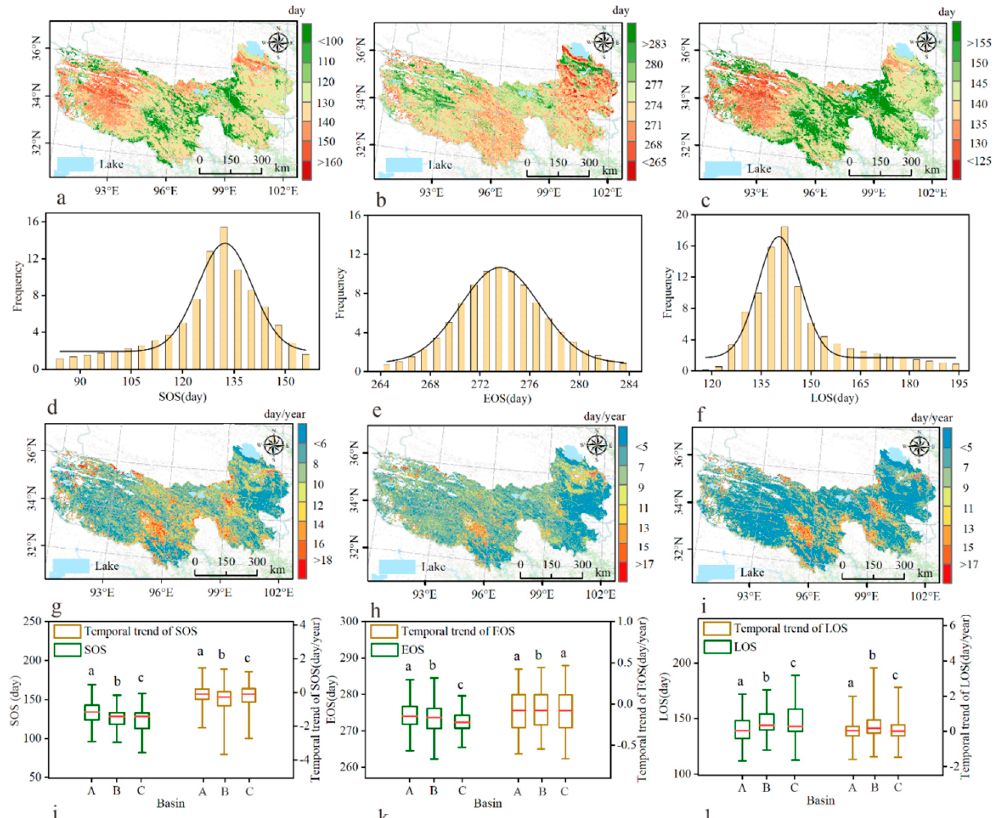
Figure 5. Spatiotemporal patterns of vegetation phenology: ( a – c ) the spatial pattern of a multi-year average of the start (SOS), end (EOS), and length (LOS) of the growing season on the Three-River Headwaters from 2001 to 2018; ( d – f ) time- frequency distribution of SOS, EOS, and LOS, respectively; ( g – i ) standard deviation for the SOS, EOS, and LOS, respectively; ( j – l ) temporal variation characteristics of vegetation phenology of (A) Yangtze, (B) Yellow, and (C) Lancang river basins in SOS, EOS, and LOS, respectively. The different letters above the box plots indicate significant differences among different basins at p < 0.05. The green boxplots indicate the overall distribution characteristics of SOS, EOS, and LOS values in different basins. The yellow boxplots indicate the overall distribution characteristics of the trend of SOS, EOS, and LOS values in different basins.